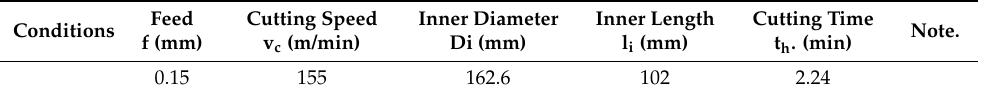
Table 2. Roughing time t h.